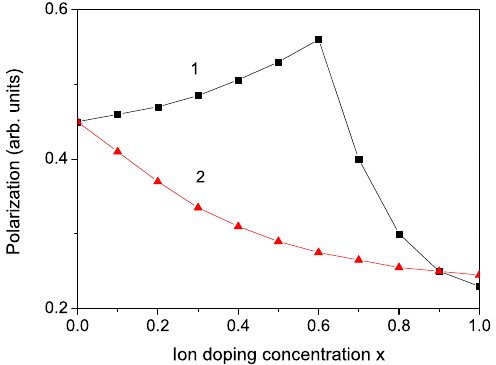
Figure 3. (Color online) Ion doping dependence of the polarization P in CCO NP, N = 10, J s 1,2,3 = 1.2 J b 1,2,3 for (1) Co - for 0 ≤ x ≤ 0.6 J d 1 = 1.2 J b 1 , for x > 0.6 J d 1 = 0.8 J b 1 ; (2) Pr - J d 3 = 0.8 J b 3 . All other interaction constants in the doped states are assumed to be nearly the same as in the undoped ones.